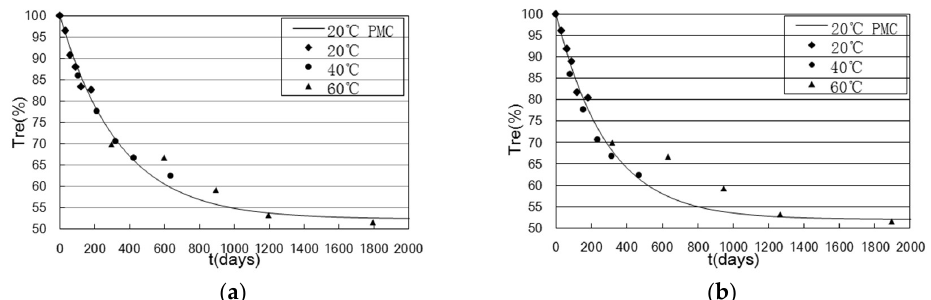
Table 8. TSF at temperatures of 20, 40, and 60 °C based on the second prediction model .